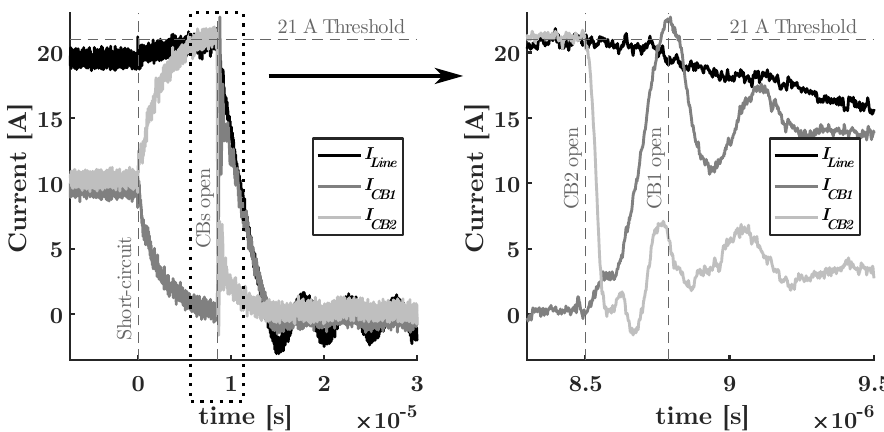
Figure 13. Experimental results for the system shown in Figure 12, showing that the commutation of inductive currents can cause unnecessary tripping (the right figure is a zoom